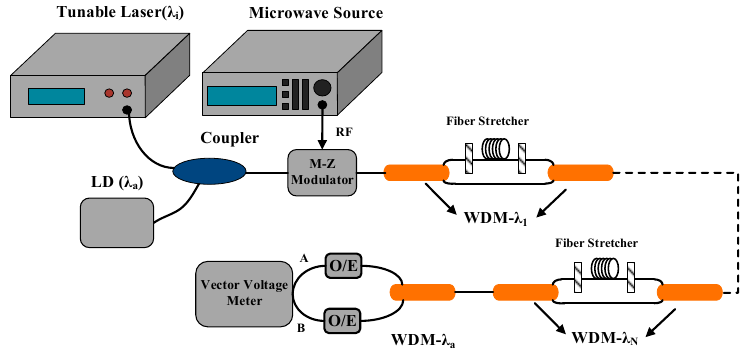
Figure 5. The fiber-optic delay based quasi-distributed strain sensor.